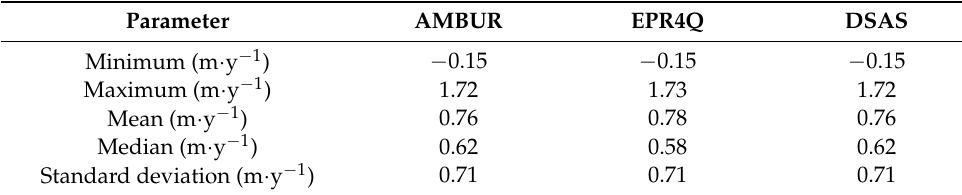
Table 4. Statistical parameters between the different methods applied to the Hampton shoreline.